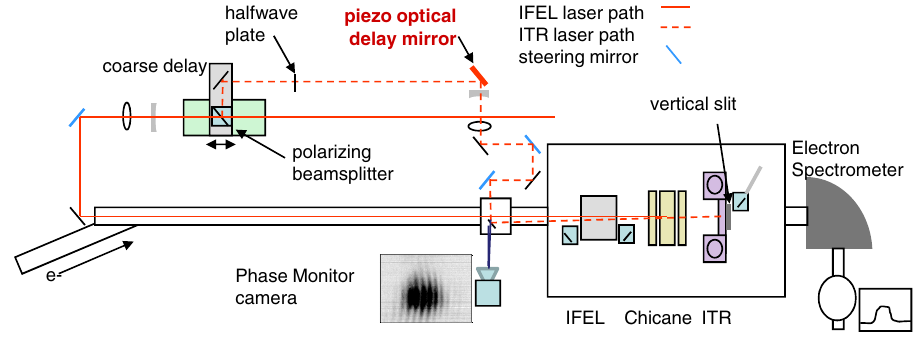
FIG. 2. (Color) Layout of the net acceleration experiment. The laser is split at a polarizing beamsplitting cube to drive both the ITR acceleration and the IFEL. The ITR path includes a piezo driven mirror for varying the optical phase. Each arm is (cid:1) 5 m in path length. Interferometric noise measurements indicate the optical paths are stable to within (cid:1) 20 nm or 2 parts per billion of the total path.